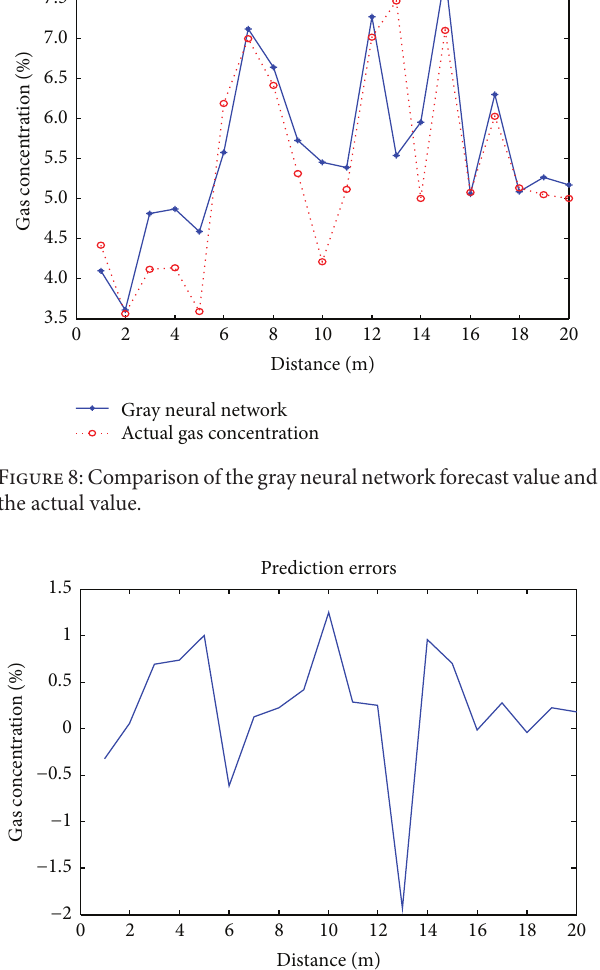
robots. Figure 8 compares the gray neural network forecast and the actual gas concentration. Figure 9 is the prediction errors of the gray neural network.